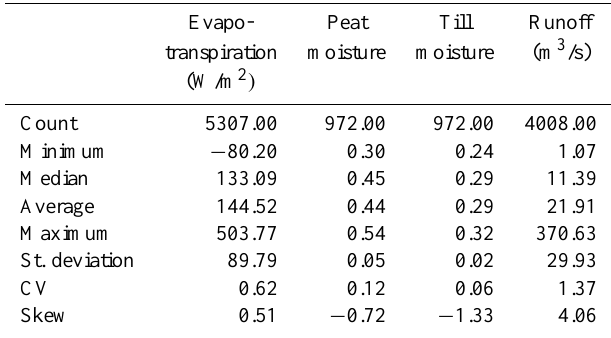
Table 3. Descriptive statistics of the output variables of all